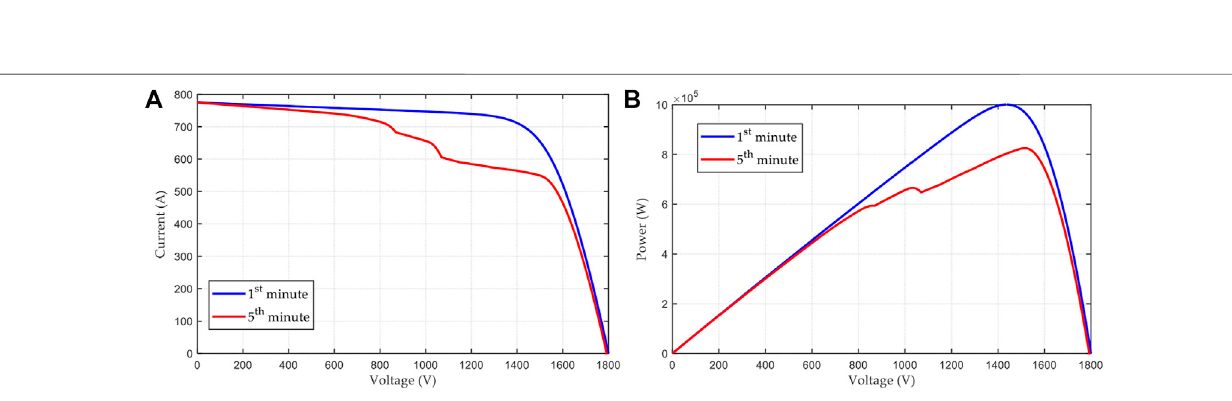
Frontiers in Energy Research |